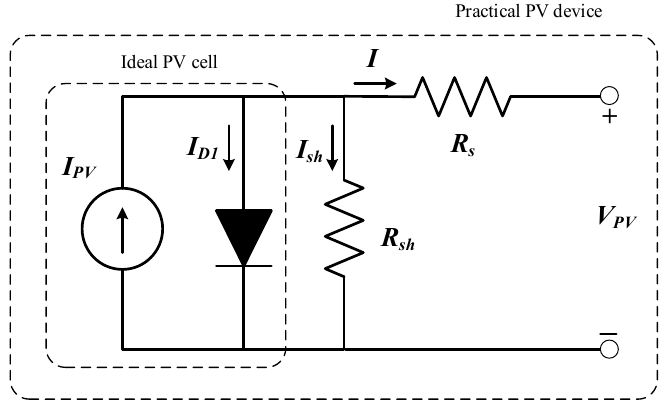
Figure 1. Circuit diagram of the single diode model.